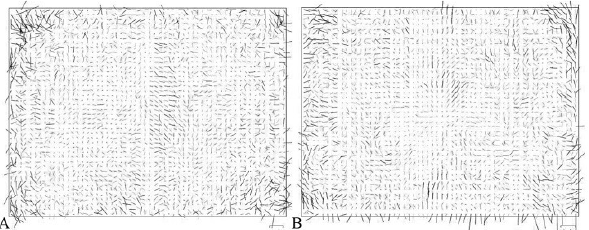
Figure 6. An example of distortion distribution: a) Xiaomi Yi 2k, b) Xiaomi Yi